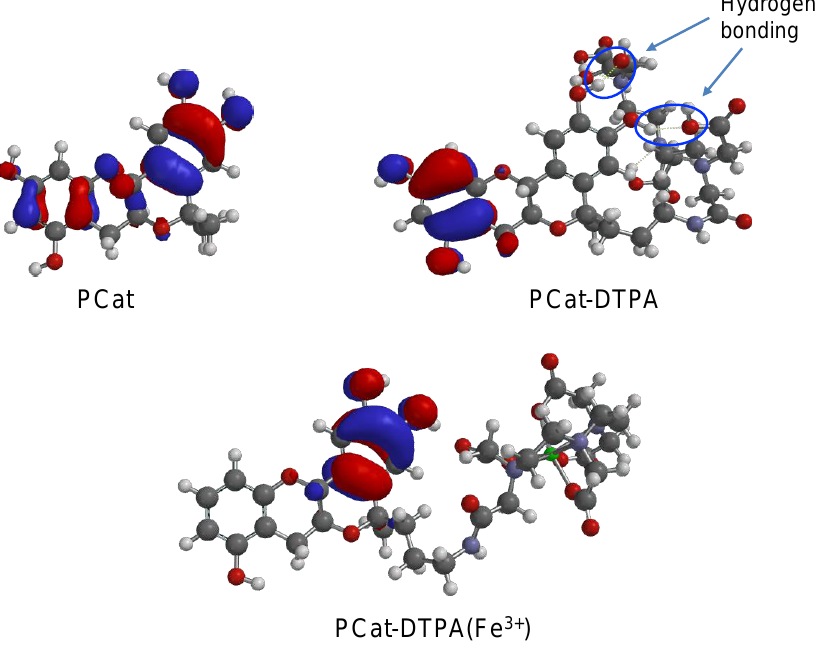
Figure 6. The optimized geometries and HOMOs of PCat, PCat-DTPA, and PCat-DTPA(Fe 3+ ) using the density functional theory at the B3LYP/6-31G*.